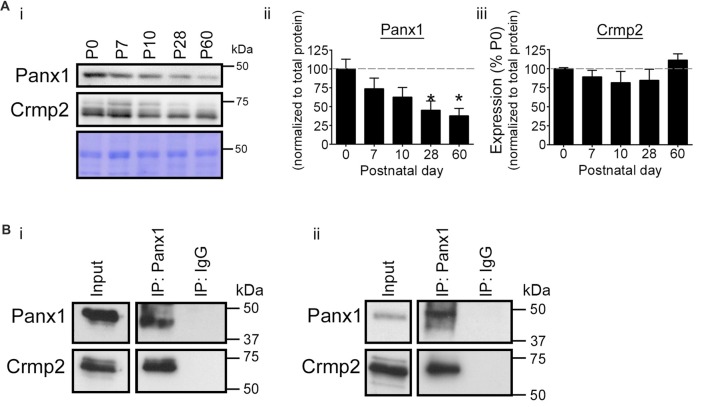
Validation of the Panx1-Crmp2 interaction in the mouse ventricular zone (VZ). (Ai) Western blot of a time course of Panx1 and Crmp2 expression in the VZ. (ii) Panx1 expression peaked within the early postnatal period (P0–P7), and dramatically decreased with age (P28–P60; p = 0.0365 by one-way analyses of variance (ANOVA); F(4,10) = 3.9; Dunnett’s multiple comparison test post hoc, P28 p = 0.0352, and P60, p = 0.0177; n = 3). Coomassie Blue was employed as a loading control. (iii) Crmp2 expression remained relatively constant across this time course (F(4,10) = 1.3; p = 0.3333, one-way ANOVA; n = 3). (B) Western blot of endogenous Panx1 IPs from mouse brain VZ tissue. Crmp2 co-precipitated specifically with Panx1 from young (P10; i) and adult (P60; ii) mouse VZ. For the complete blots of part (B), see Supplementary Material. This data was previously included in the PhD thesis of LWS (link: https://dspace.library.uvic.ca/handle/1828/6938).